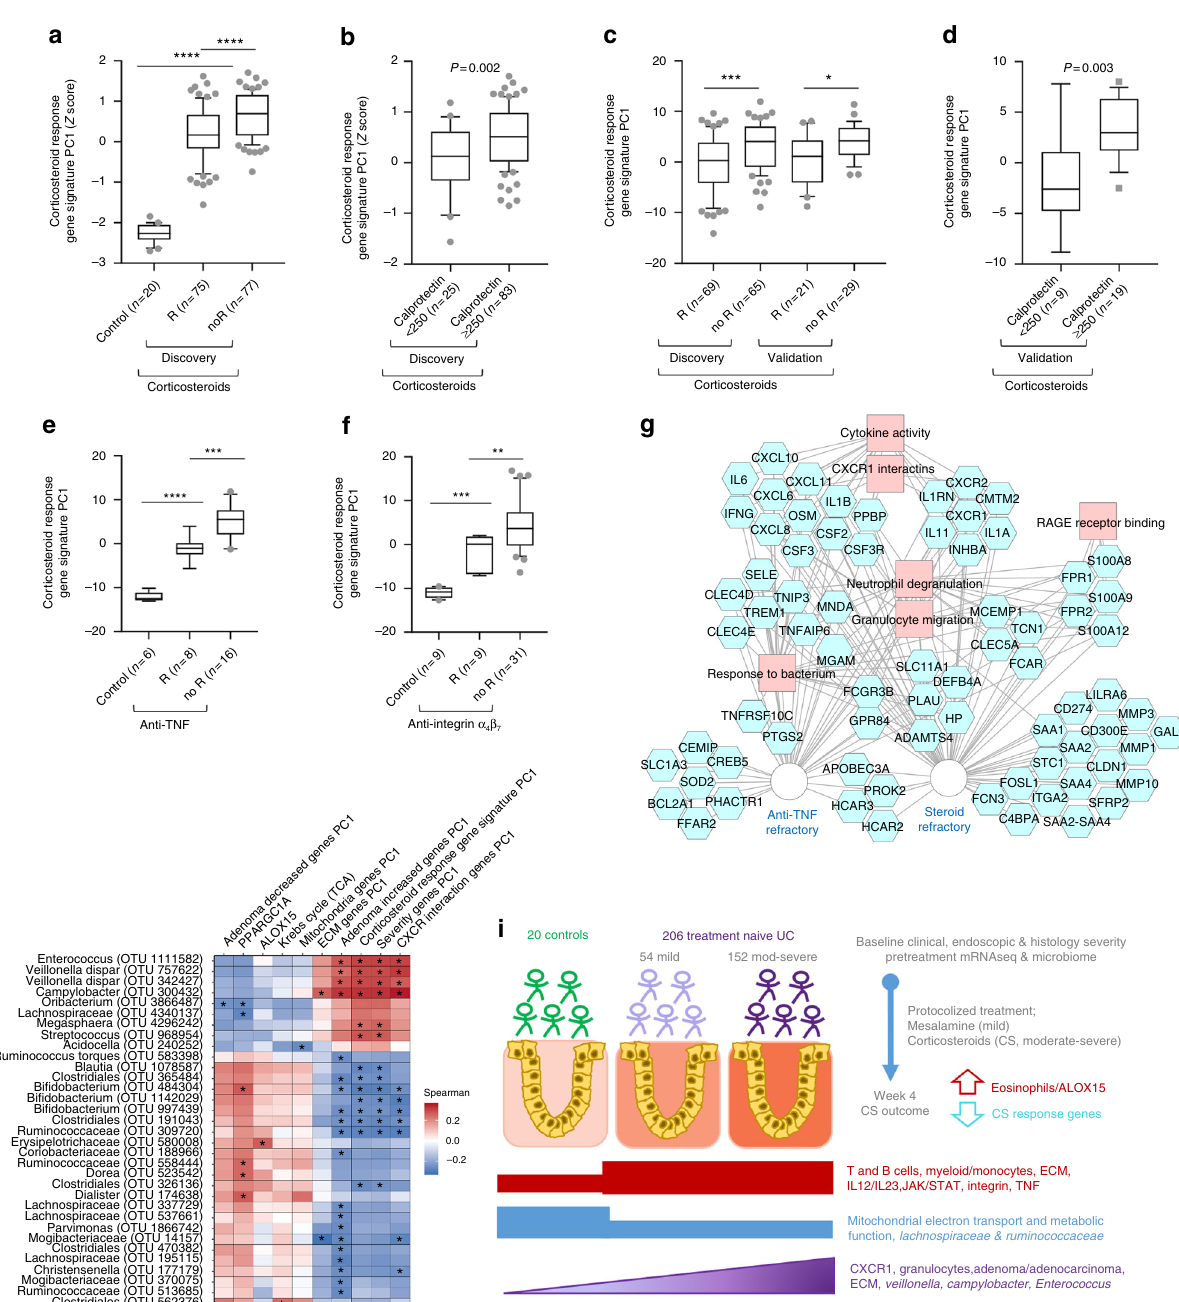
Fig. 4 A rectal gene signature is associated with response to UC induction therapy and microbial shifts. Samples loading PC1 (Z score) values of the corticosteroid response gene signature are shown for controls and the discovery cohort of 152 moderate-severe UC patients strati fi ed by a WK4 clinical remission (R) and b mucosal healing (fecal calprotectin < 250 mcg/gm). Samples loading PC1 values derived from an independent 3 ′ UTR Lexogen mRNASeq platform are shown for the discovery cohort and an independent validation cohort strati fi ed by c WK4 clinical remission (R), or by d mucosal healing as in ( b ) for the validation cohort. Samples loading PC1 values including controls and e the GSE16879 20 data set of UC treated with anti-TNF and f GSE73661 23 of UC treated with anti-integrin α 4 β 7 . R: mucosal healing de fi ned by colonoscopy. g Functional annotation enrichment analyses of the corticosteroid response gene signature and the top 50 genes that were differentially expressed in pretreatment colon biopsies of anti-TNF refractory vs. responsive UC patients 21 . The full list of enriched functions and P values are in Supplementary Dataset 4. Genes are in blue and biologic functions in pink; connections to each signature are as shown. h Heat map summarizing Spearman similarity measures between microbial abundances and gene expression using hierarchical all-against-all association. *False discovery rate < 0.2. Blue and red indicate negative and positive associations, respectively. i Graphical summary of the cohort and main fi ndings. Box and whisker plot with central line indicating median, box ends representing upper and lower quartile, and whisker represent 10 – 90 percentile. Mann − Whitney and ANOVA FDR as applicable, * P < 0.05, ** P < 0.01, *** P < 0.001, ****<0.0001